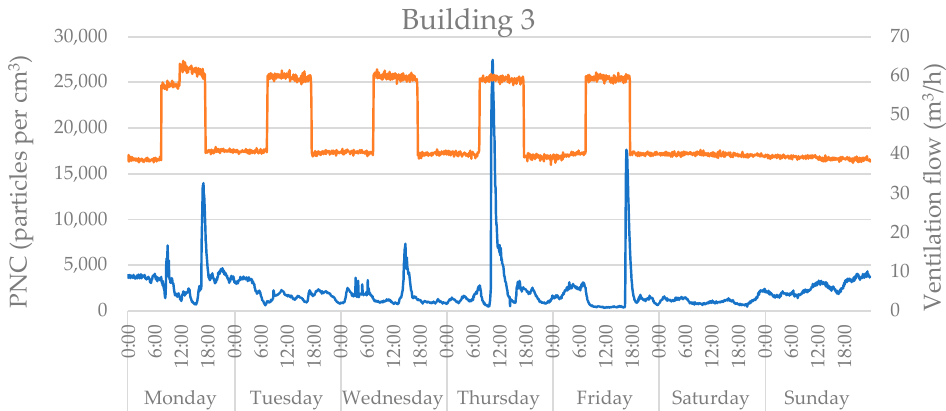
Figure 6. The NP number concentration (blue line) and the ventilation flow (orange line) in Building 3 during the heating season. The NP concentrations and the ventilation flow were measured in five-minute intervals.